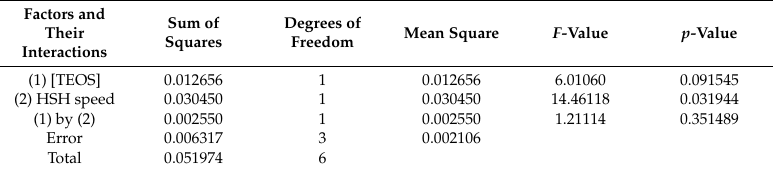
Figure 1. Graphical representation of the interaction between the independent variables on SiNP properties (factorial design experiment set in Table 1). Surface response plots of the effect of TEOS concentration and HSH speed on Z-Ave (A) and PI (C) of SiNP. Pareto chart of the effect of TEOS concentration and HSH speed on Z-Ave (B) and PI (D) of SiNP. Vertical lines in Pareto chart indicate the critical effect at 95% confidence level. Table 3. Evaluation of TEOS concentration ([TEOS]) and HSH speed and their interactions. Analysis of PI by analysis of variance (ANOVA) statistical test.